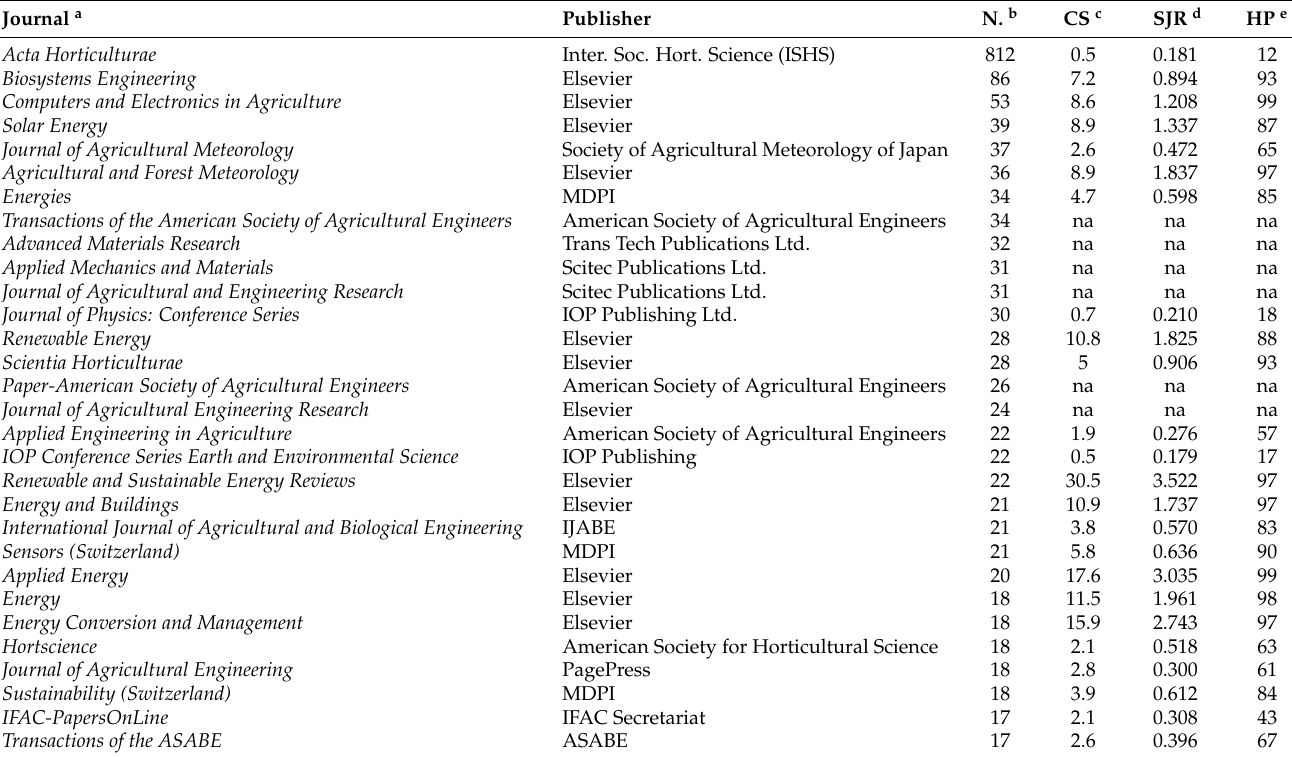
Table 1. Publisher, number of documents, Scopus CiteScore (CS), Scimago Journal Rank (SJR) and highest CiteScore percentile (HP) of the top journals publishing studies on greenhouse